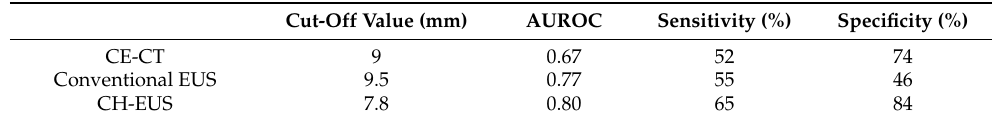
Table 4. Diagnostic Abilities for Malignancy According to the Size of Mural Lesion on CE-CT, Conventional EUS, and CH-EUS.